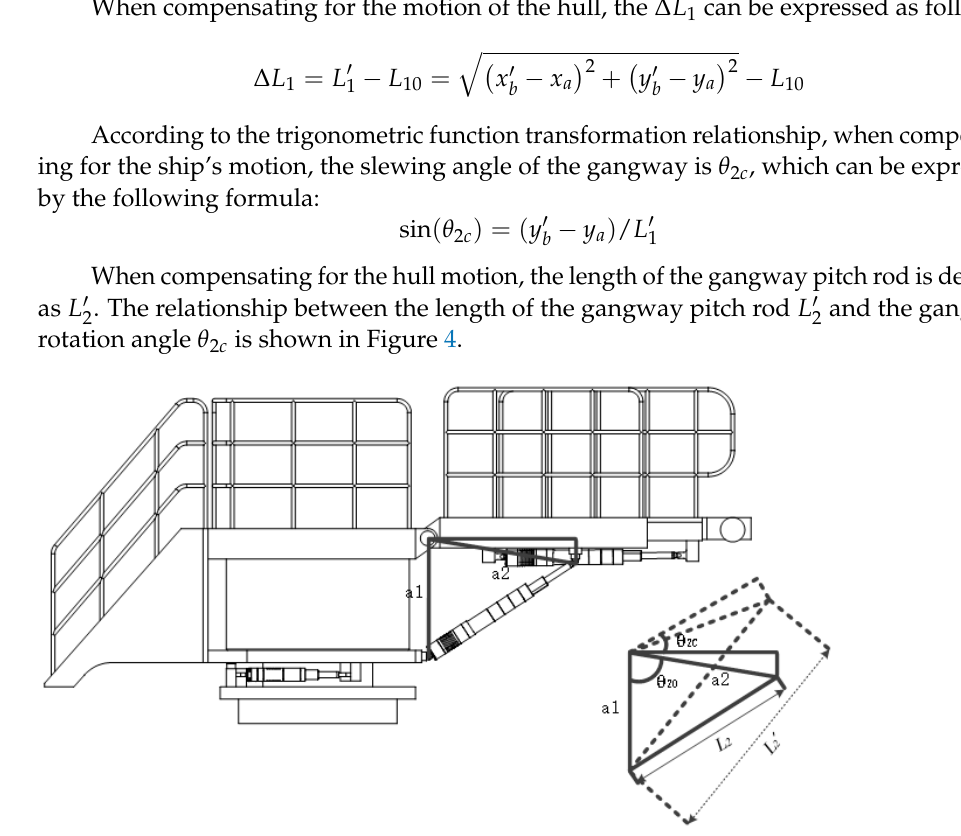
Figure 4. Relationship between the length of the pitch rod and the rotation angle.